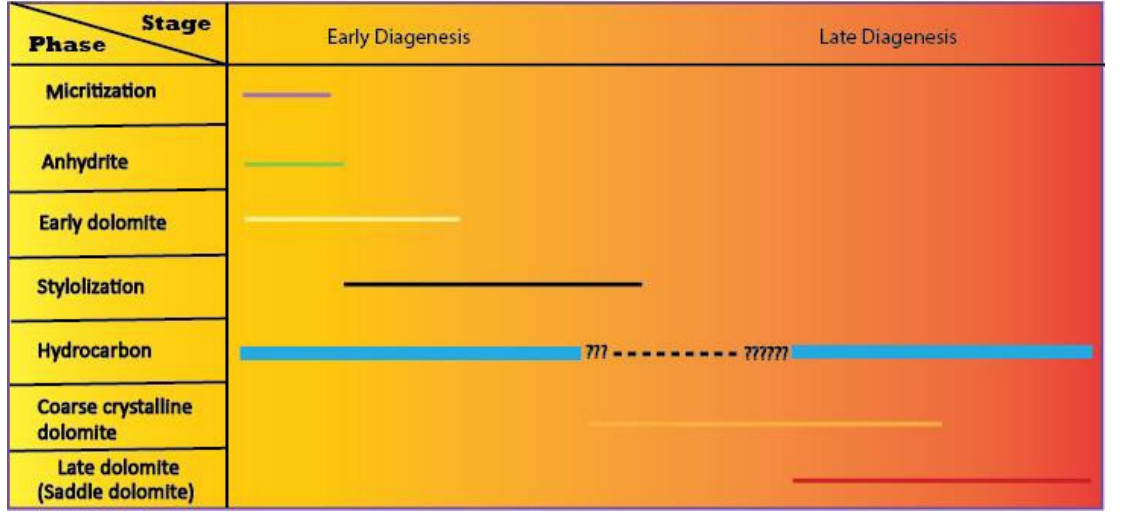
Figure 8. Paragenetic sequence of early and late diagenesis influenced the carbonates of the Qam- chuqa Formation. Scale = 16 m.